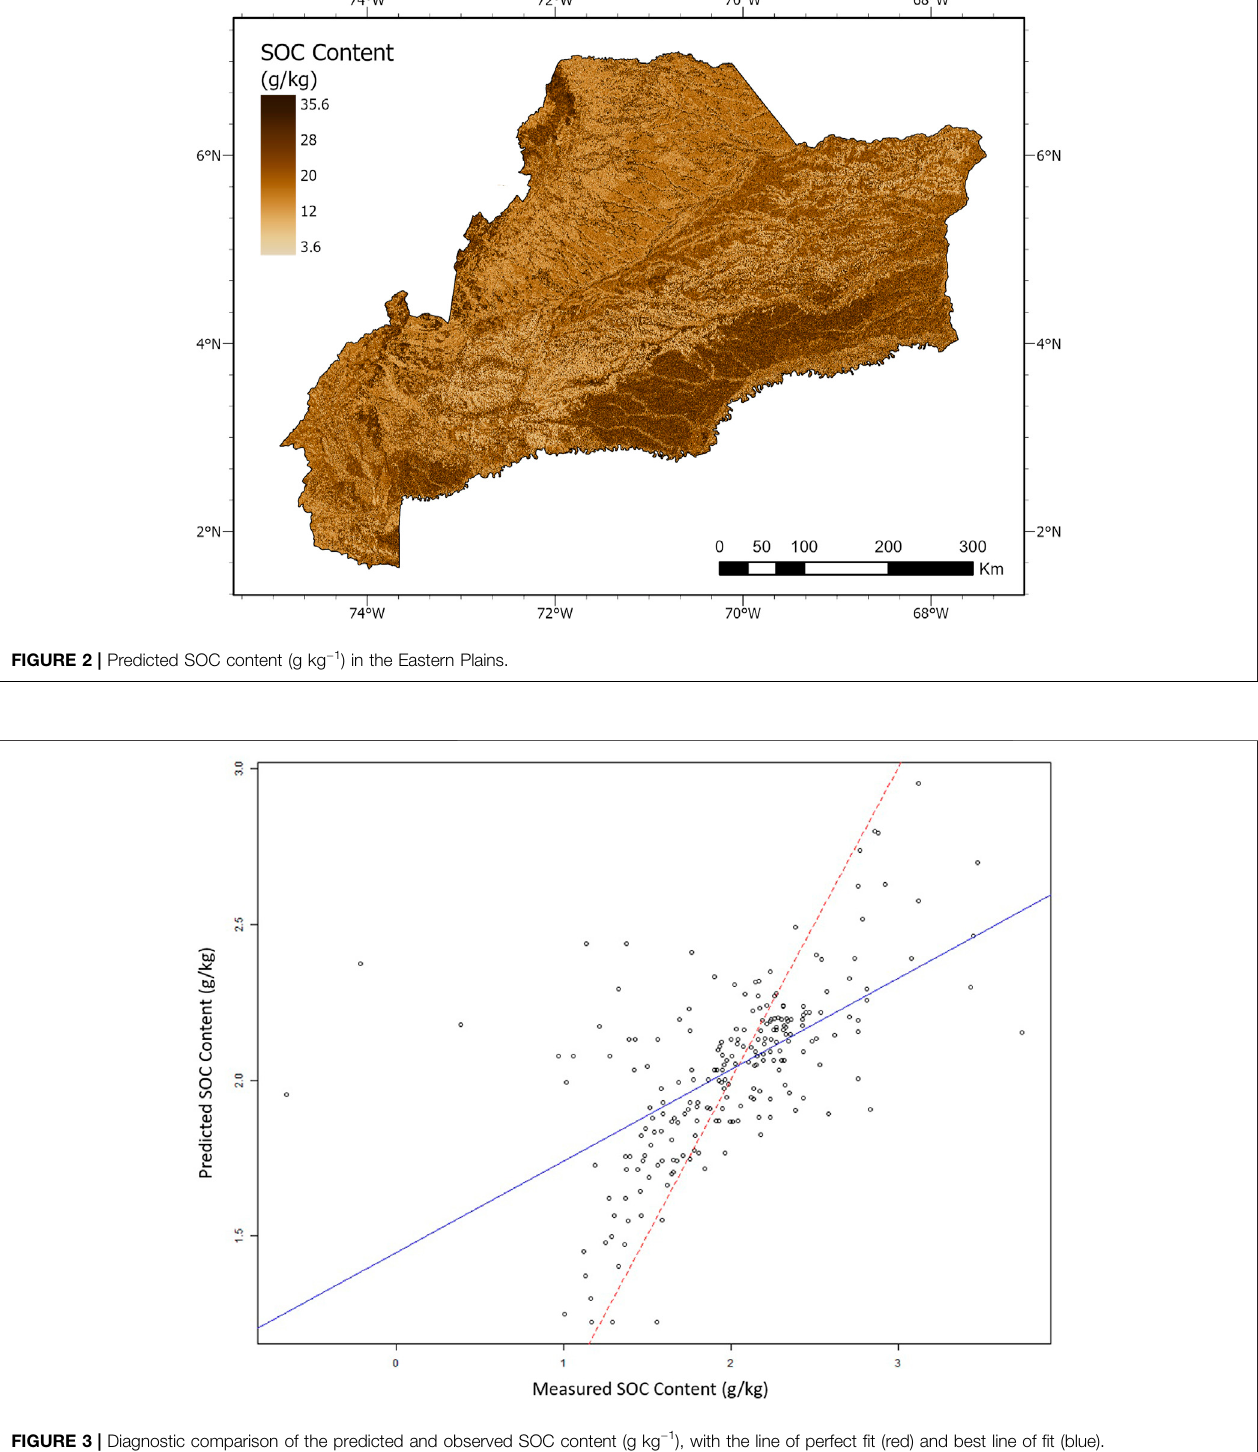
Frontiers in Environmental Science |